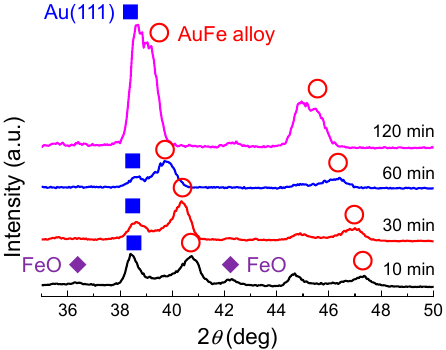
Figure 9. XRD patterns of particles obtained by different laser irradiation time onto the mixed colloidal solution of Au50 in ethanol.